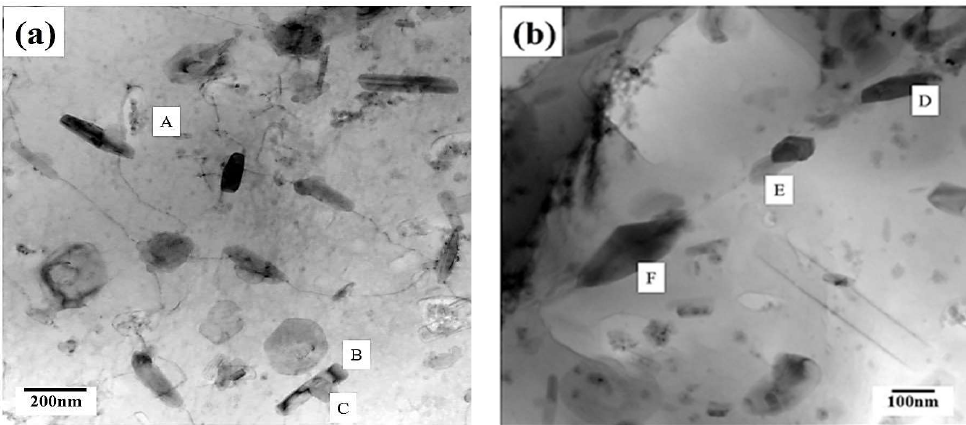
Figure 10. The precipitate analysis of the 1670-NA specimen by TEM: ( a ) matrix; and ( b ) grain boundary.